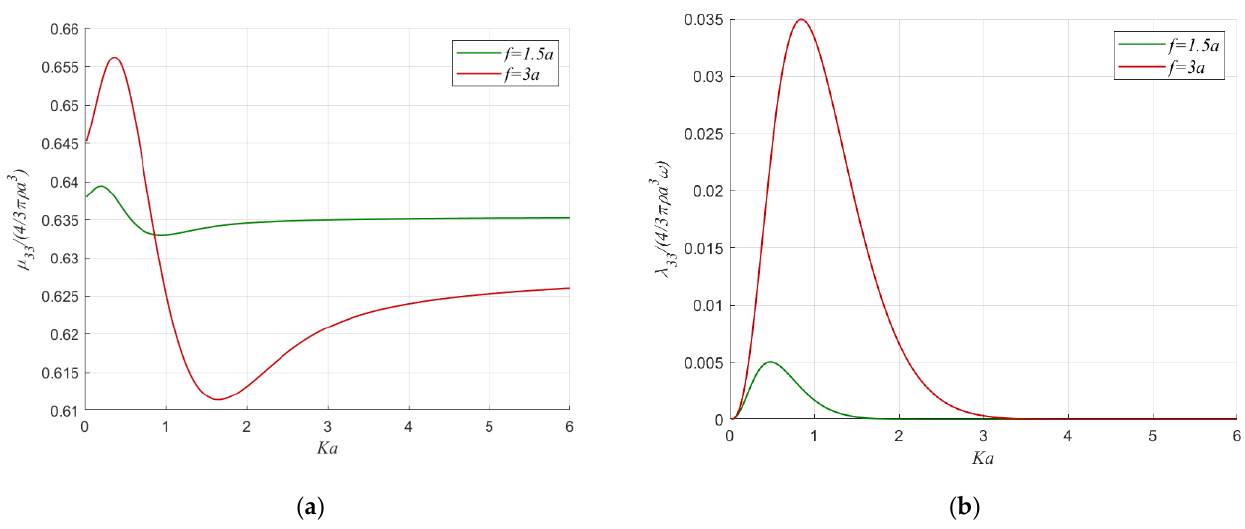
Figure 13. Normalized hydrodynamic coefficients in heave for a disc: ( a ) added mass; ( b ) hydrody- namic damping.